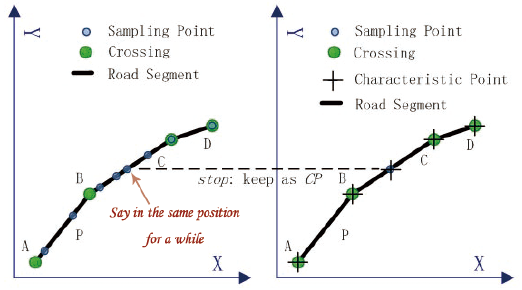
Fig. 2. Trajectory partitioning, find stops in trajectory and keep them as characteristic points